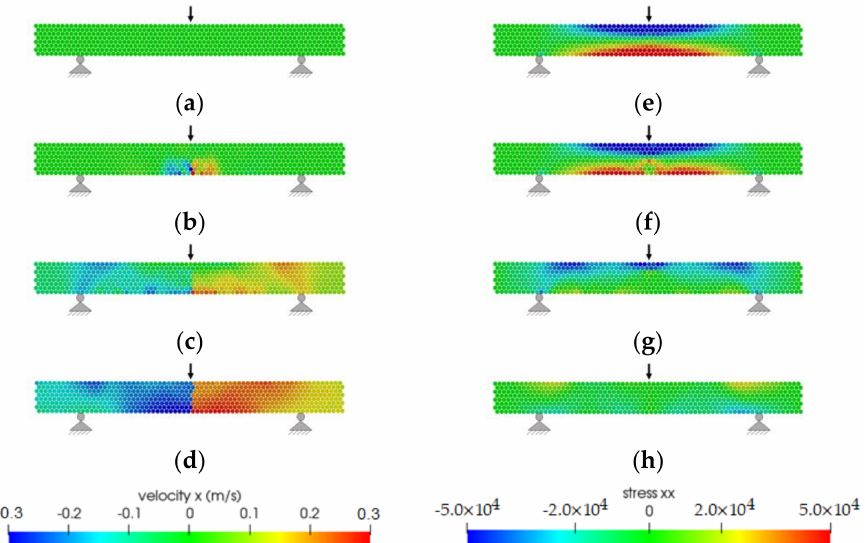
Figure 3. Failure process of three-point bending test: left column presents x -directional velocity; right column presents normal stress in the x -direction. ( a ) t = 0.4792 s; ( b ) t = 0.4794 s; ( c ) t = 0.4796 s; ( d ) t = 0.4800 s; ( e ) t = 0.4792 s; ( f ) t = 0.4794 s; ( g ) t = 0.4796 s; ( h ) t = 0.4800